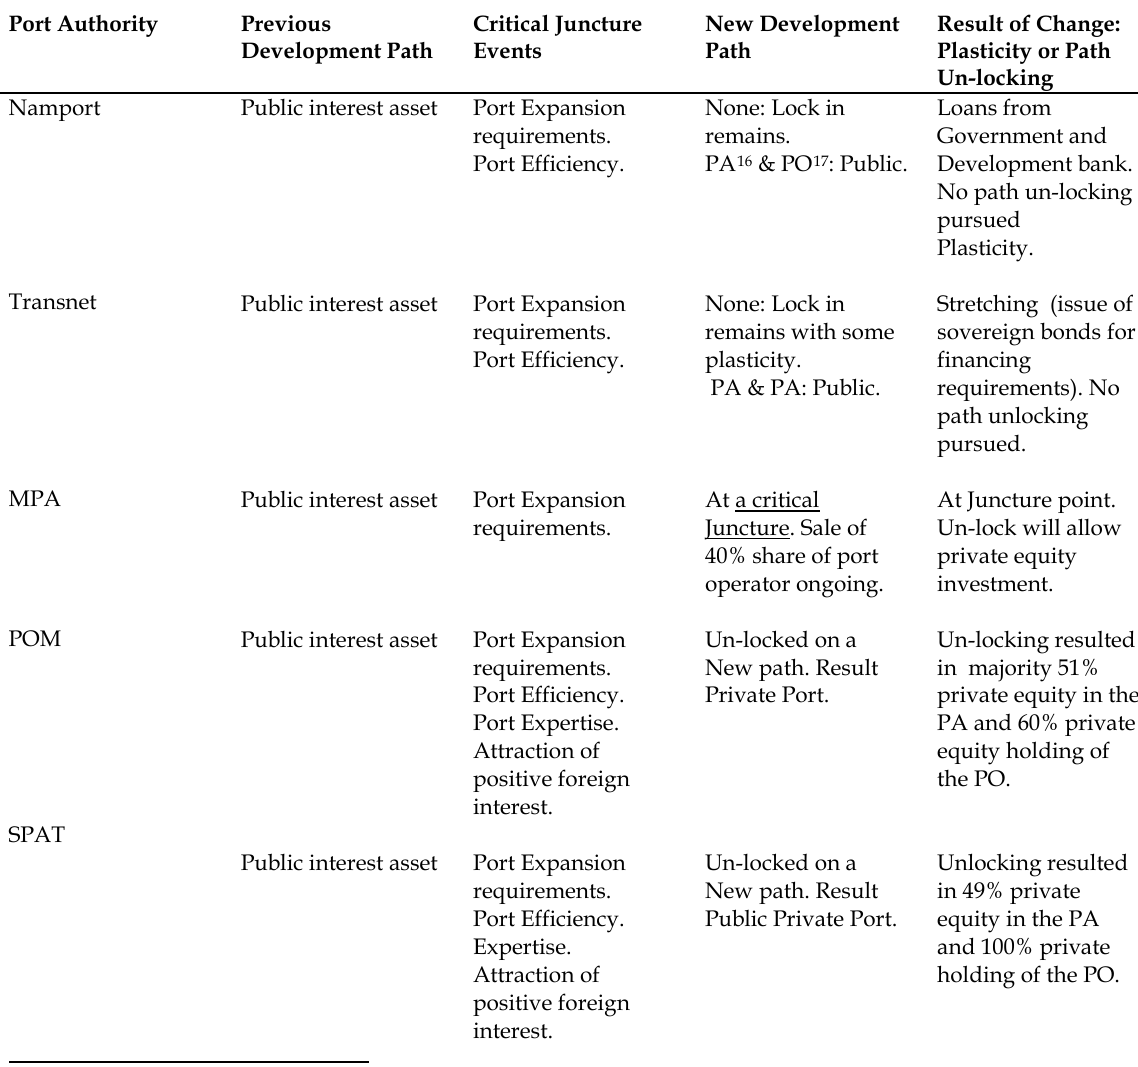
Table 5. Institutional Development Paths in container ports of Southern Africa Port